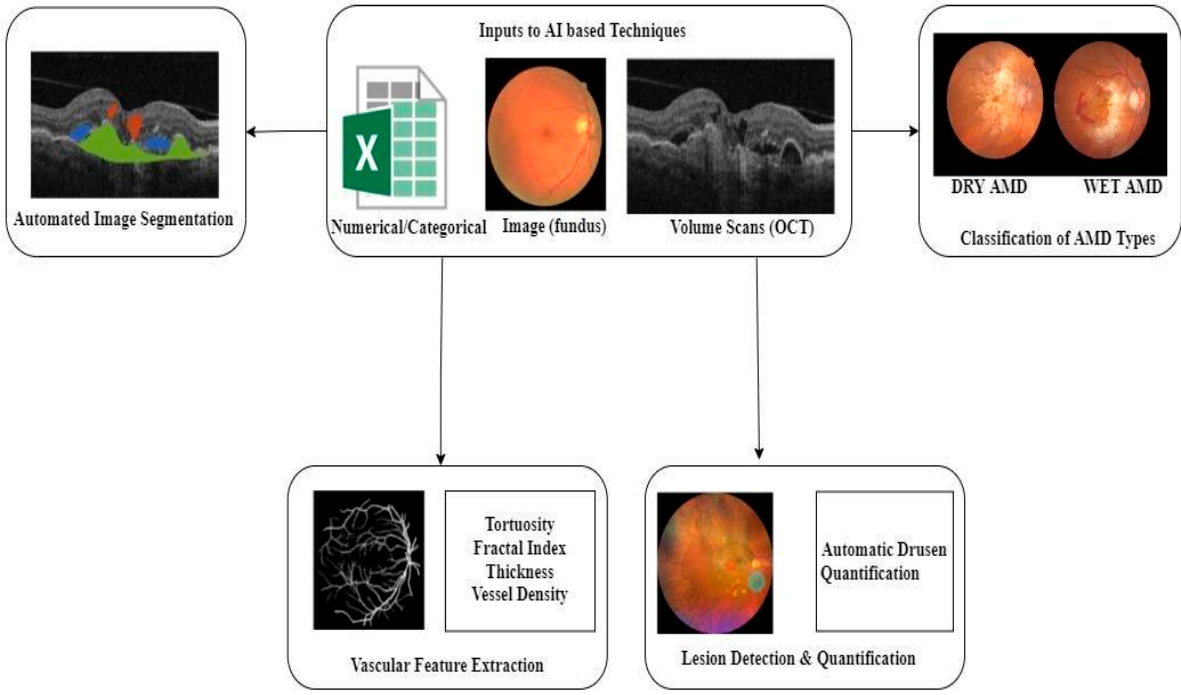
Figure 5. Applications of artificial intelligence from the perspective of a